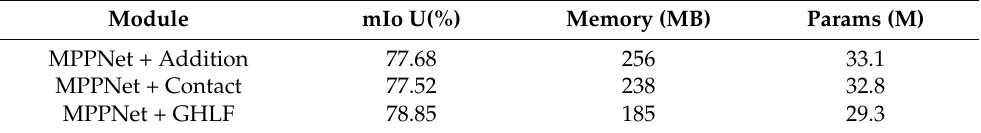
Table 4. Computational cost comparison of MPPNet with different feature fusion operations.